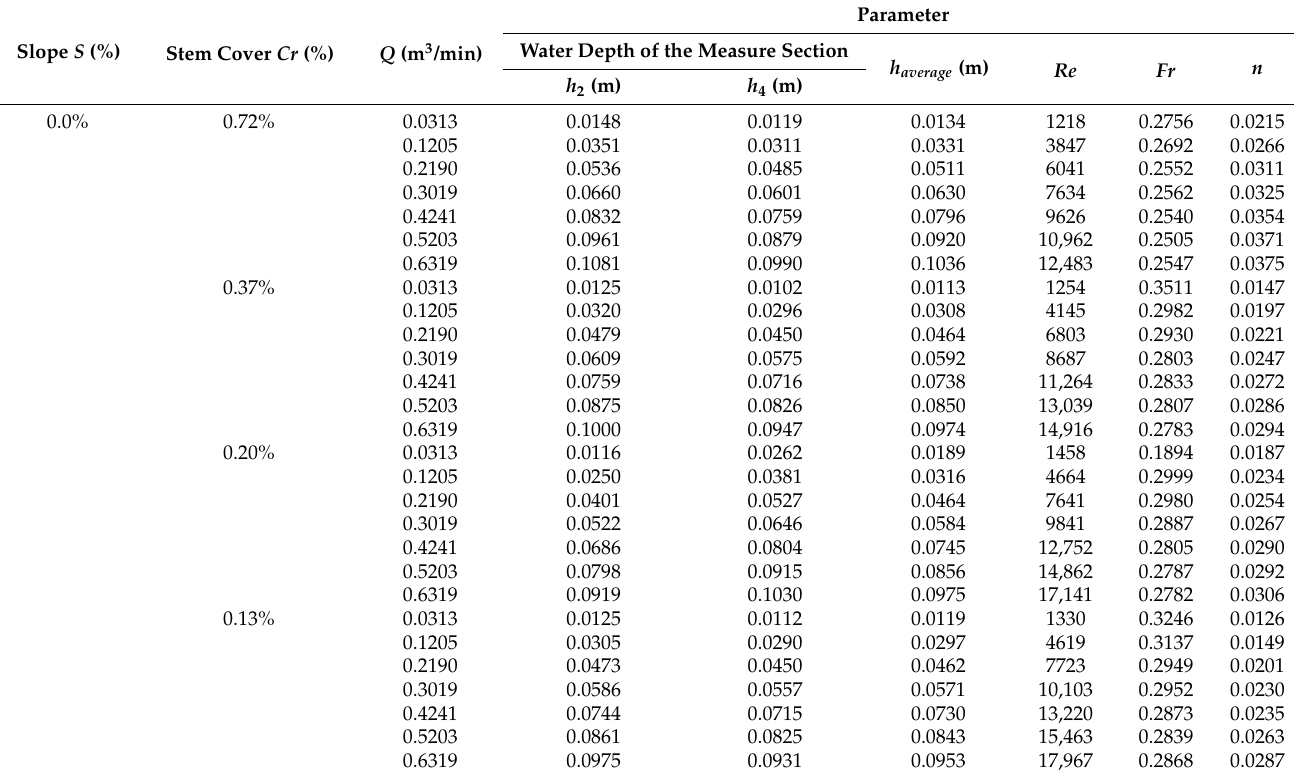
Table 1. Experimental data of hydraulic parameters of six different vegetation stem cover under the condition of S = 0.0% ( Cr is 0.72%, 0.37%, 0.20%, 0.13%, 0.11% and 0.07%, respectively).